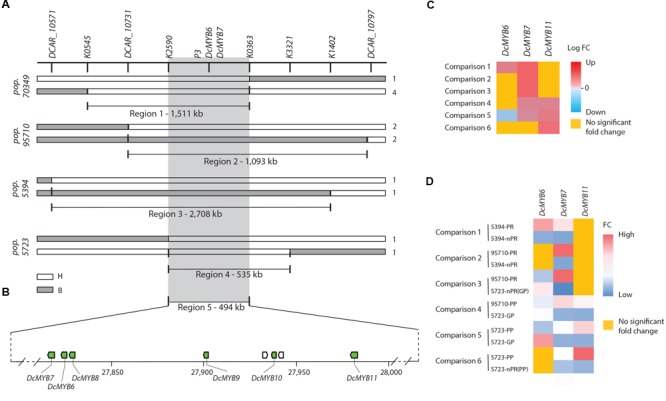
Fine mapping summary and comparative transcriptome analysis. (A) Haplotypes delimiting the genomic regions controlling the RTPE-Q1 QTLs in 70349 (region 1) and the P3 locus in 95710, 5394 and 5723 (regions 2–4). Genotyping scores to draw this figure were extracted from Supplementary Figure S2. The white bars indicate the heterozygous haplotypes (H = Aa) and the gray bars indicate the homozygous recessive haplotypes (B = aa). Region 5 represent the genomic sequence delimited by the nearest markers flanking the RTPE-Q1 QTL and the P3 locus across regions 1–4. Numbers on the right side of each bar represent the number of recombinant genotypes for each haplotype. (B) Schematic representation of carrot chromosome 3 containing regions 1–5 and the six anthocyanin related DcMYB6-11 (green boxes). The scheme was drawn to scale. (C) RNASeq results for DcMYB6-7-11 across 6 comparisons: The heatmap represents the log fold changes (Log FC) of expression level for each comparison. Positive values (>0, from light red to dark red) indicate down-regulation, negative value (<0, from light blue to dark blue) indicates up-regulation. Genes not differentially expressed across the 6 comparisons are highlighted in yellow. (D) qRT-PCR results for DcMYB6-7-11 across 6 comparisons. The heatmap represent the average mean fold changes in gene expression normalized to internal control genes ACTIN. The value in each cell was calculated by averaging the qRT-PCR results obtained from 3 biological replication and three technical replications. qRT-PCR normalized by EF-1α were consistent with the results presented here and are included in Supplementary Figure S6. Genes not differentially expressed are highlighted in yellow.